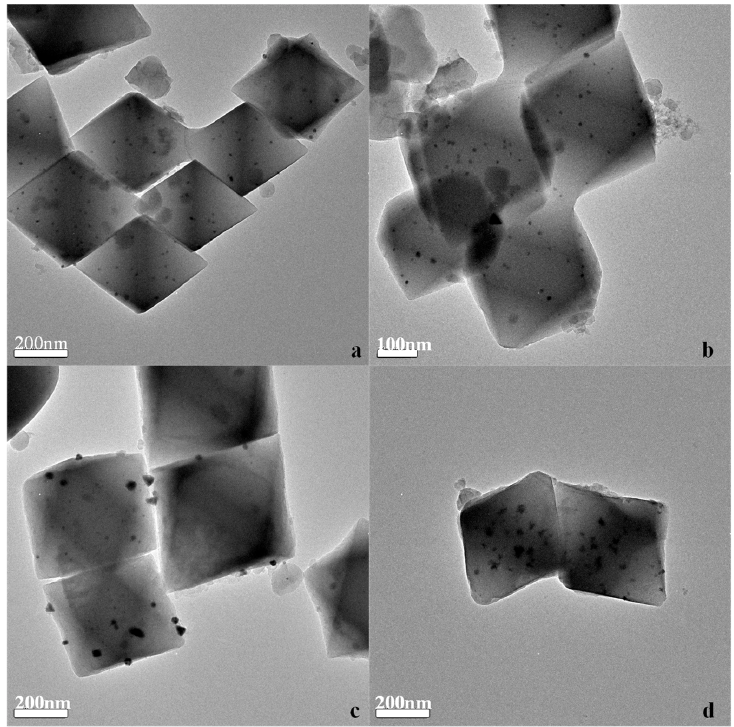
Figure 3. TEM images of ( a ) 0.1% Pd@U ( b ) 0.2% Pd@U ( c ) 1% Pd@U ( d ) 2% Pd@U.